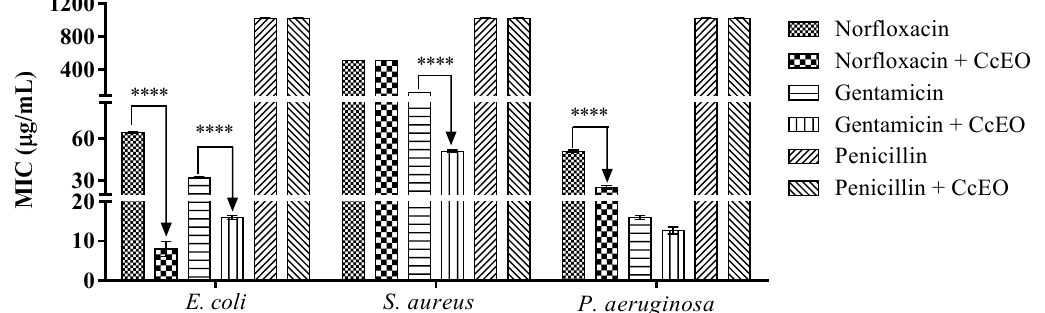
Figure 1. Antibiotic-Modulating e ff ect of Croton ceanothifolius (CcEO) essential oil against multidrug resistant bacteria. **** Statistical Significance p <